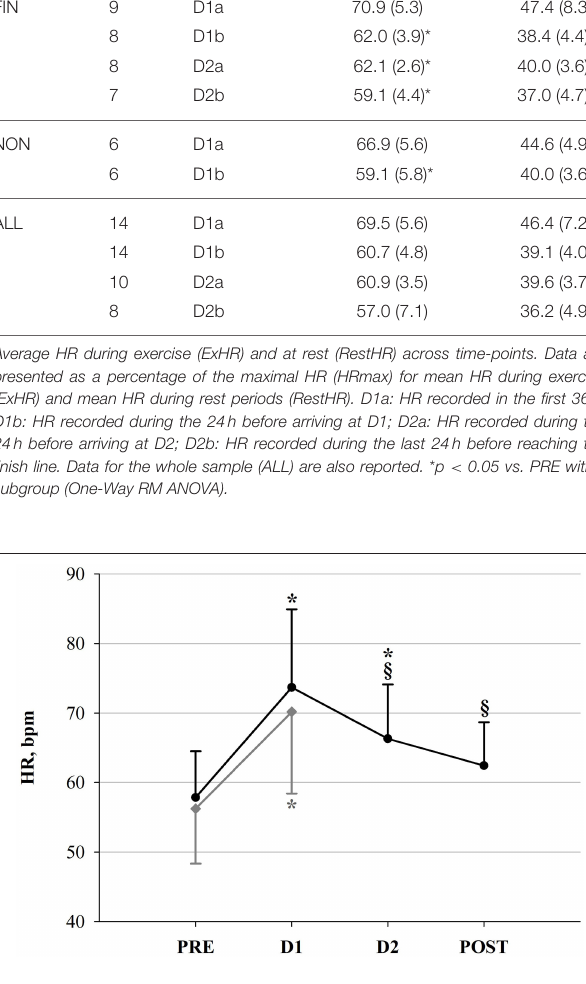
FIGURE 3 | Heart Rate (HR) in FIN (black line) and in NON (gray line) across time-points. * p < 0.05 vs. PRE within subgroup (One-Way RM ANOVA). § p < 0.05 vs. D1 (One-Way RM